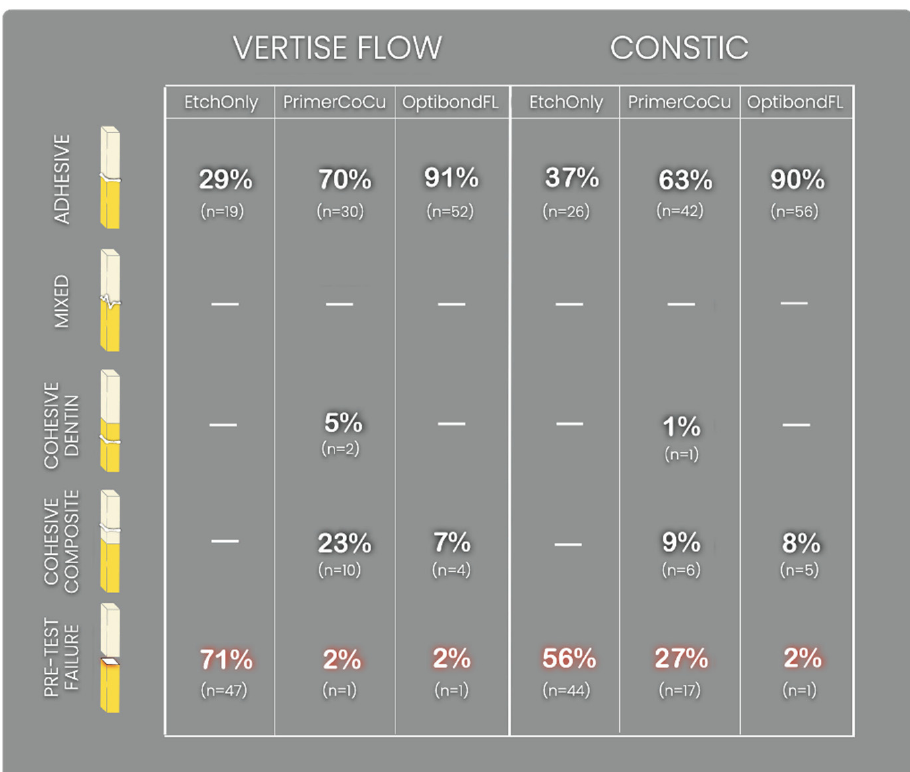
Figure 7. Summary of the fractographic analysis showing the different types of failures seen in each experimental group (presented as %). Pre-test failure indicates beams that fractured before bond strength tests were carried out.